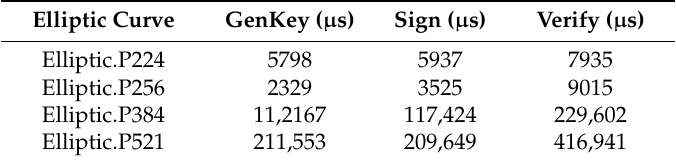
Table 8. ECC execution time on Raspberry PI4b ARMv7 Raspbian GNU / Linux 10. Elliptic